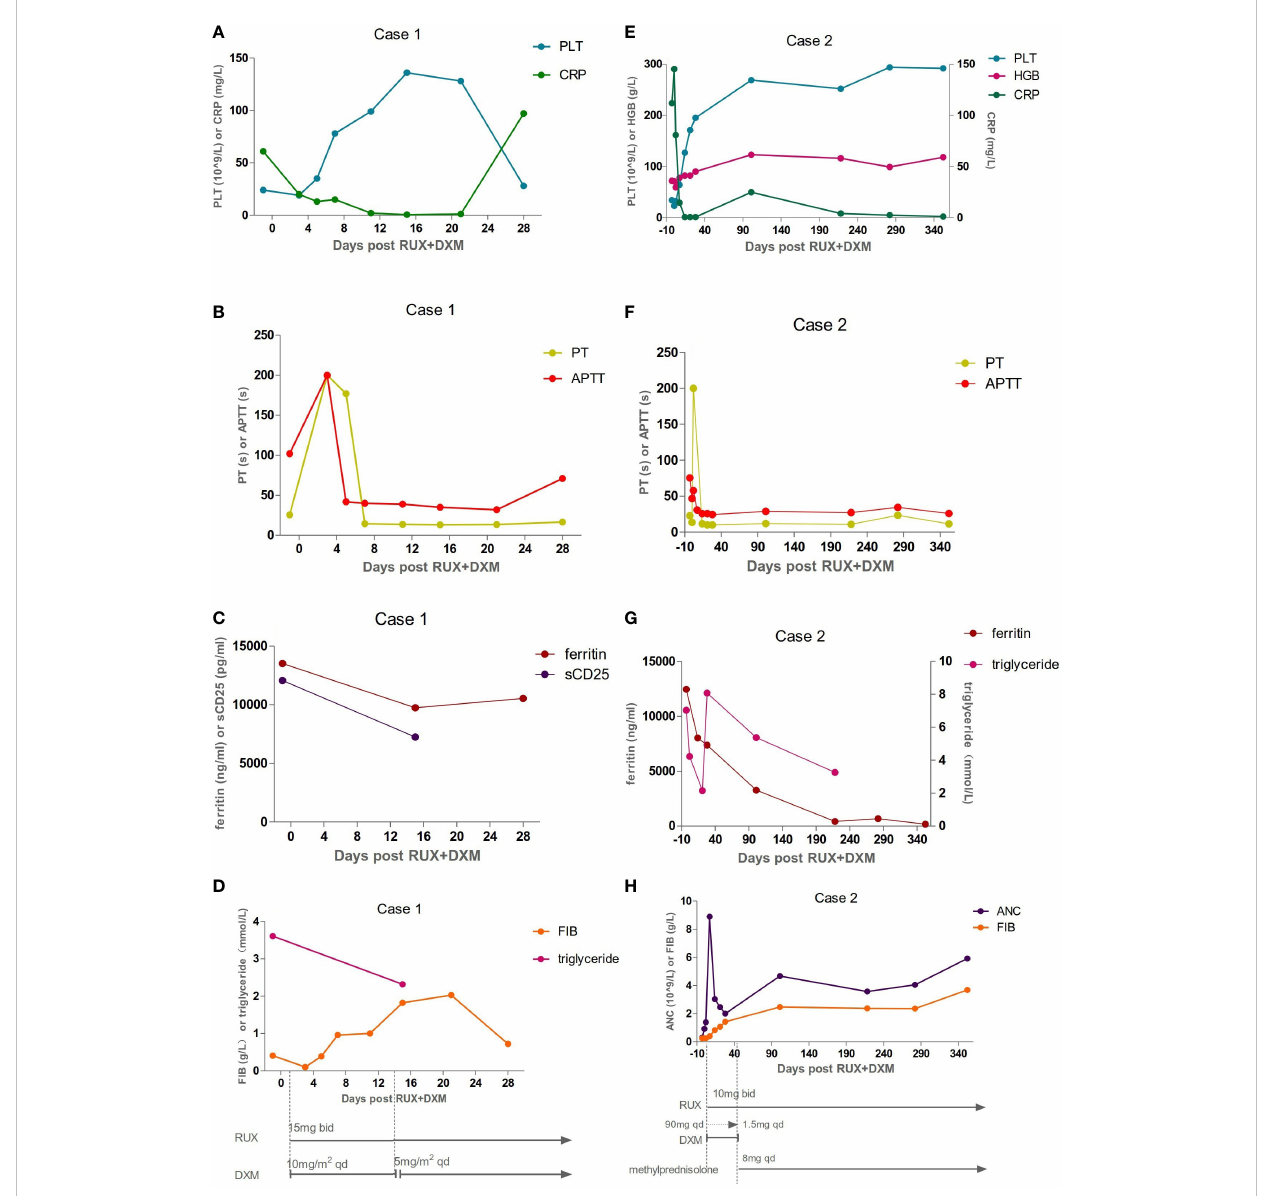
FIGURE 1 In fl ammatory, coagulation function, and hematologic responses to HLH therapies: Day 0 corresponds to ruxolitinib (RUX) initiation. Treatment schedules, lines, and bars represent continuous therapy and individual doses of drugs with intermittent schedules. Arrows indicate that treatment was continued. (A – D) The laboratory assessments of Case 1. The levels of platelet (PLT), prothrombin time (PT), active thromboplastin time (APTT), C-reactive protein (CRP), fi brinogen (FIB), ferritin, soluble CD25 (sCD25), and triglyceride were abnormal before Day 0 and gradually improved